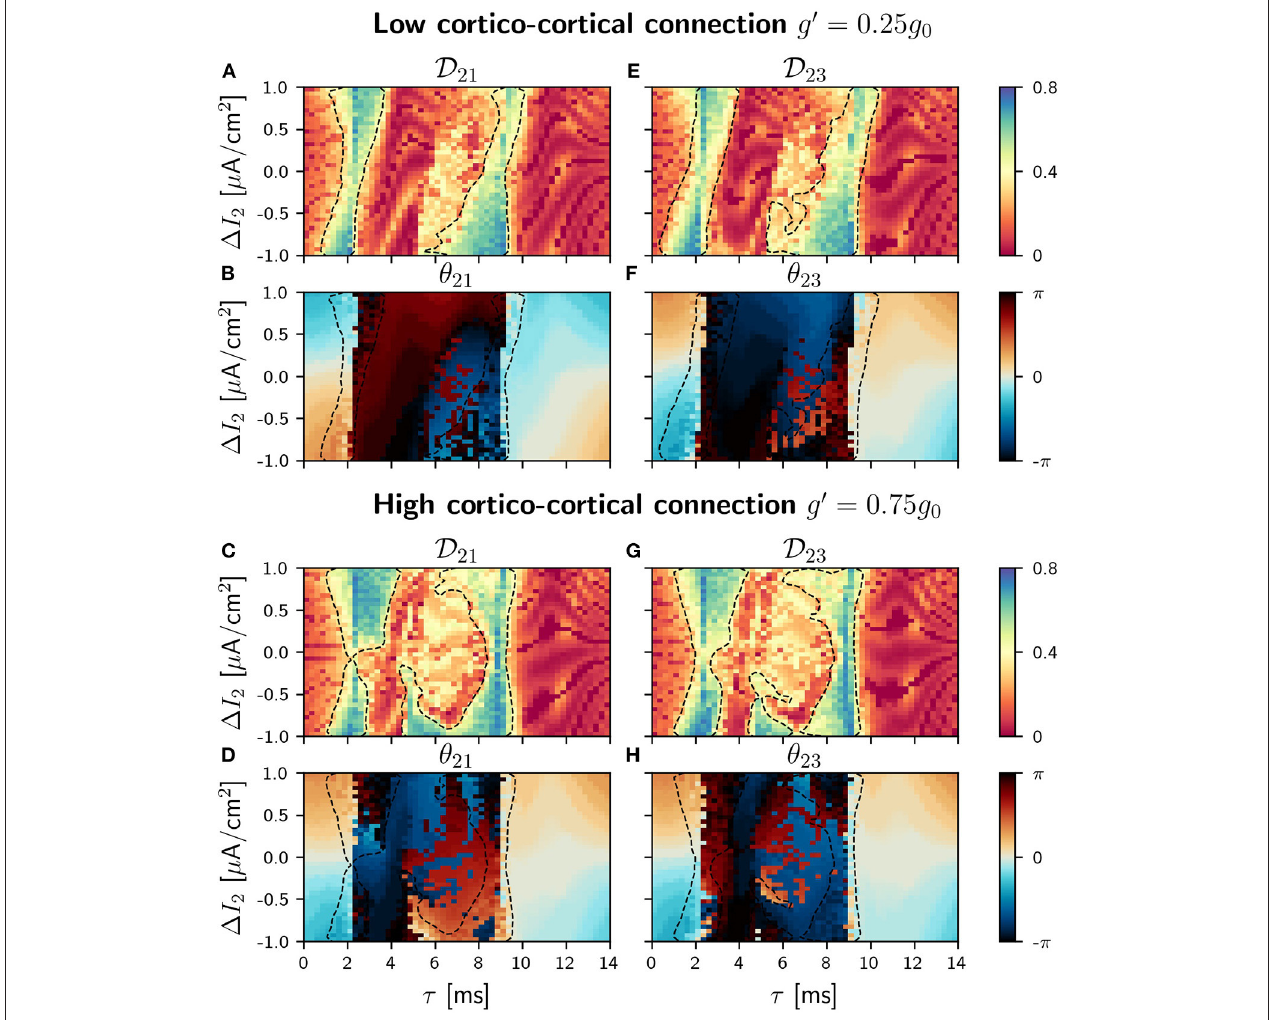
0.25 g 0 (A and E) and g ′ 0.75 g 0 (C and G) . Phase difference θ ij for g ′ = =